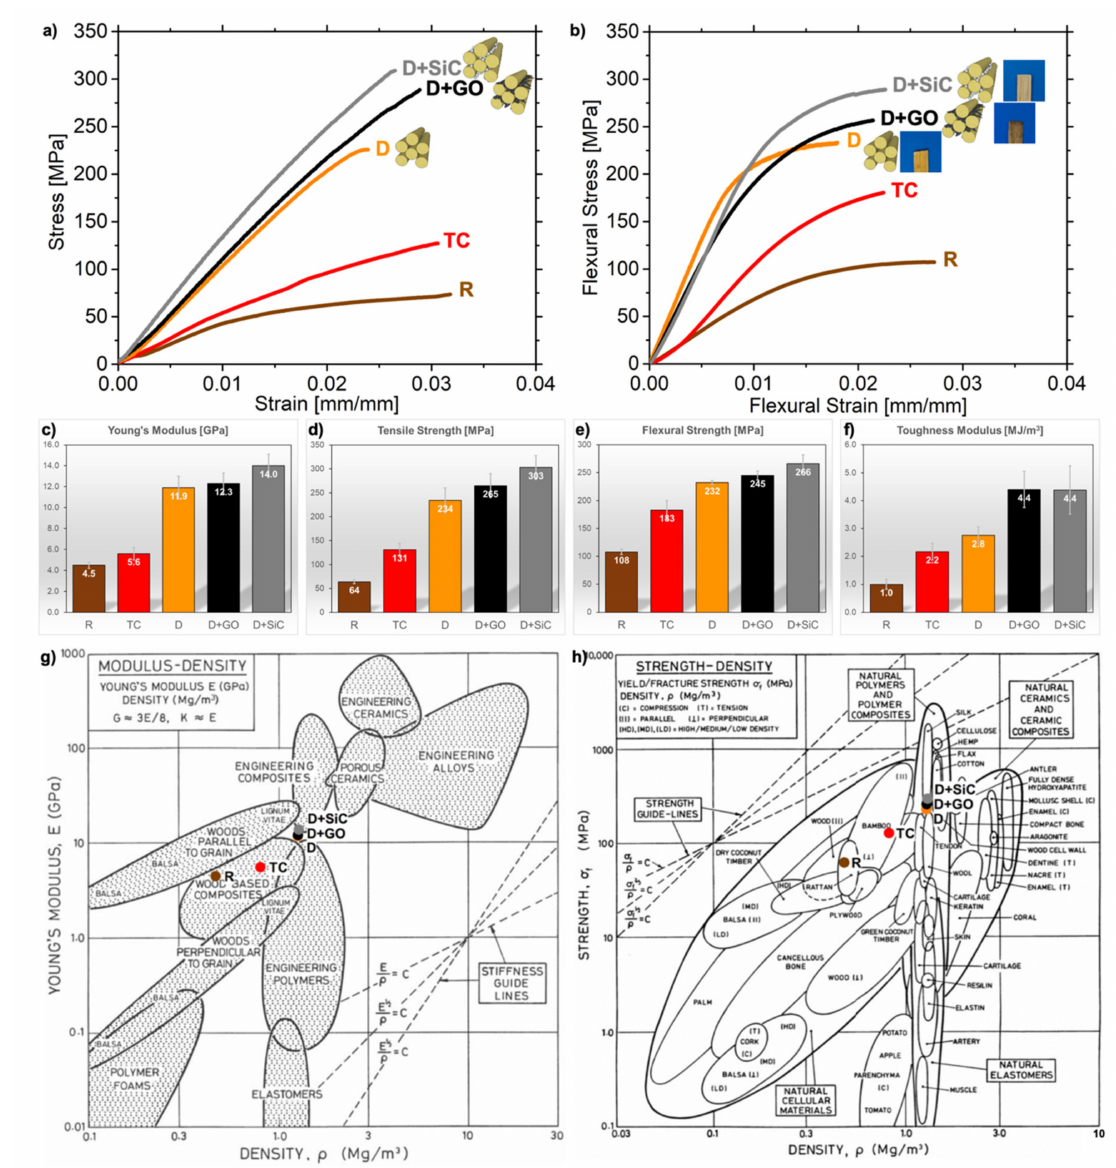
Figure 3. Average representative ( a ) stress-strain and ( b ) flexural stress-strain curves. Simplified representation of CMFs with GO flakes and SiC nanoparticles is given for D, D + GO, D + SiC. After the addition of nanoparticles, samples’ color change as shown (D + GO veers towards black while D + SiC veers towards gray). Histograms summarizing the properties of R, TC, D, D + GO, and D + SiC samples: ( c ) Young’s modulus, ( d ) tensile strength, ( e ) flexural strength, and ( f ) toughness modulus (area under the tensile stress-strain curve). Error bars represent the standard deviation. Material properties charts show the five materials of this work compared to common engineering materials: ( g ) Young’s modulus vs. density chart and ( h ) strength vs. density chart - adapted from [17] with permission. In the Ashby charts, the final densified products sit above the strength and sti ff ness guidelines traced using reed as the reference